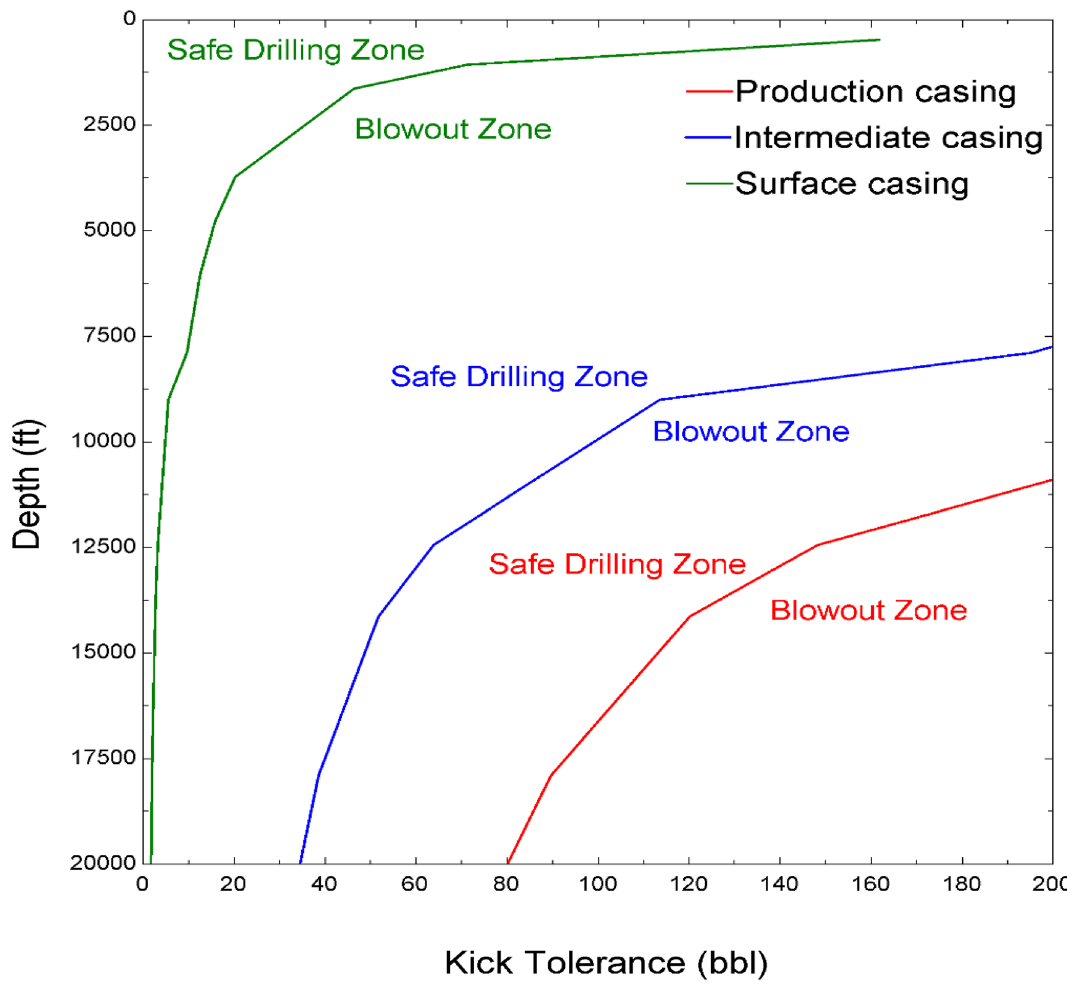
Table 8 Cement slurry volume calculation for the cementing Type of casing Open hole diam-